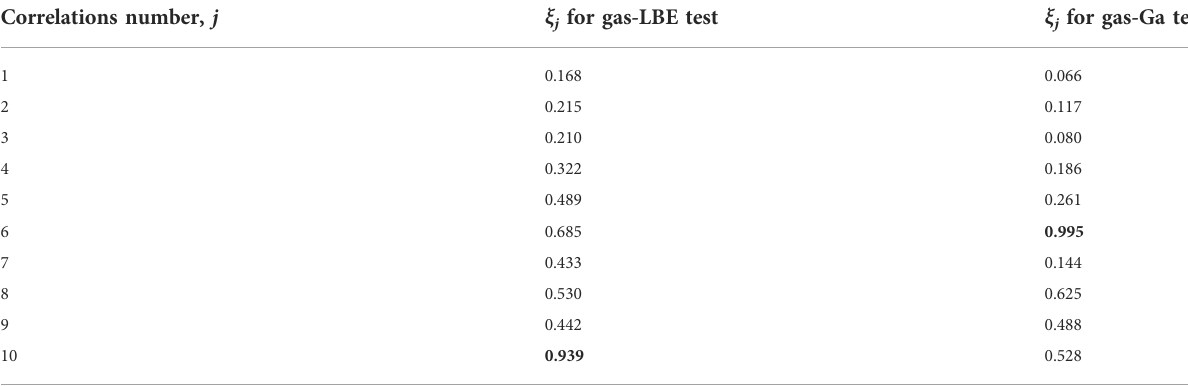
TABLE 4 Comparison of the predicted performance of all of the correlations, in terms of the benchmark coef fi cient ξ j . Correlations number,